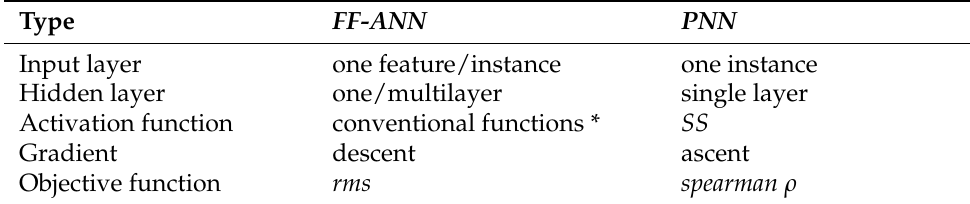
Table 1. Comparison between classical FF-ANN and PNN .